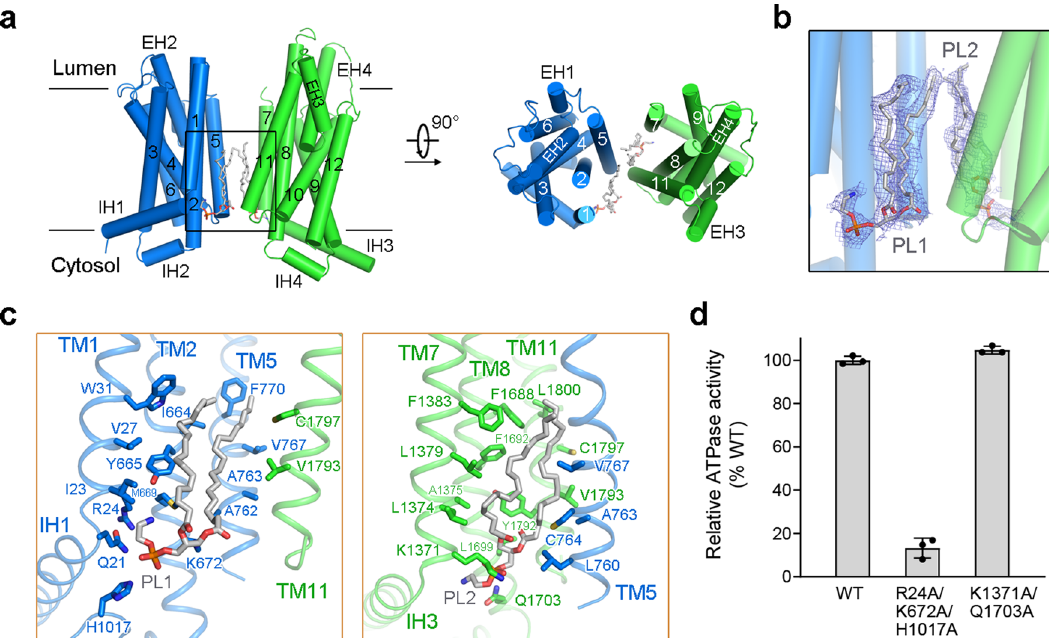
Fig. 2 Two phospholipids bound to the TMDs in the cytoplasmic lea fl et. a The TMDs of ABCA4 exhibit a lateral-opening conformation with two phospholipids bound in the cytoplasmic lea fl et. TMD1 and TMD2 are colored marine and green, respectively. The phospholipids are shown as gray sticks. b Electron density maps of the two bound phospholipids. The density maps, shown as blue mesh, are contoured at 3 σ . c Close-up views of the two phospholipid-binding sites. Key residues that mediate the interactions are shown as sticks. Two clusters of polar and charged residues near the membrane cytoplasmic lea fl et might contribute to coordinate the polar heads of phospholipids. d Functional veri fi cation of key residues that might be involved in coordinating the polar heads of phospholipids. The ATPase activities of two ABCA4 variants were normalized relative to that of the wild-type (WT) ABCA4. For all dot-plot graphs, each data point is the average of three independent experiments, and error bars represent the s.d. Source data for graph ( d ) are provided as a Source Data fi